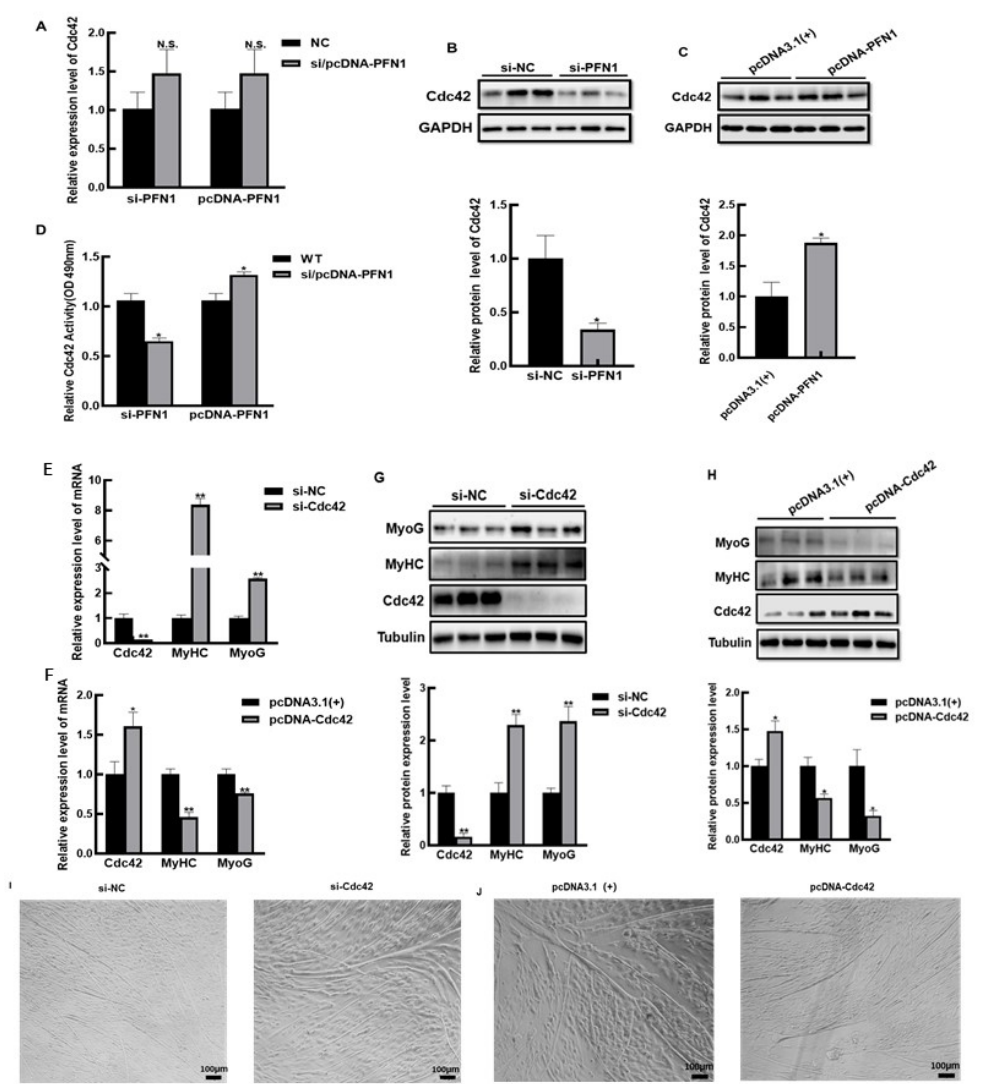
Figure 3. Regulation of Cdc42 by PFN1 and the effect of Cdc42 on the differentiation of bovine myoblasts: ( A ) qRT-PCR detecting the effect of interfering or overexpression of PFN1 on Cdc42 mRNA level in DM2 myoblasts; ( B ) Western blot detecting the effect of interfering with PFN1 on Cdc42 protein level in DM2 myoblasts; ( C ) Western blot detecting and quantitative analysis of the effect of overexpression of PFN1 on Cdc42 protein levels during differentiation; ( D ) the Cdc42 activity analysis in interfering or overexpression of PFN1 DM2 myoblast; ( E ) qRT-PCR detection of the mRNA expression level of differentiation marker genes in si-Cdc42 or si-NC transfected DM2 myoblasts; ( F ) qRT-PCR detection of the mRNA expression level of differentiation marker genes in pcDNA-Cdc42 or pcDNA3.1(+) transfected DM2 myoblasts; ( G ) Western blot analysis of differentiation marker protein levels in si-Cdc42 or si-NC transfected DM2 myoblasts; ( H ) Western blot detecting and quantitative analysis of differentiation marker protein levels in pcDNA-Cdc42 or pcDNA3.1(+) transfected DM2 myoblasts; ( I ) myotube formation status in si-Cdc42 or si-NC transfected DM2 my- oblasts; ( J ) myotube formation status in pcDNA-Cdc42 or pcDNA3.1(+) transfected DM2 myoblasts. si-NC stands for negative control, and pcDNA3.1(+) stands for empty vector control negative control. N.S.: non significance, * p < 0.05, ** p < 0.01, and *** p <